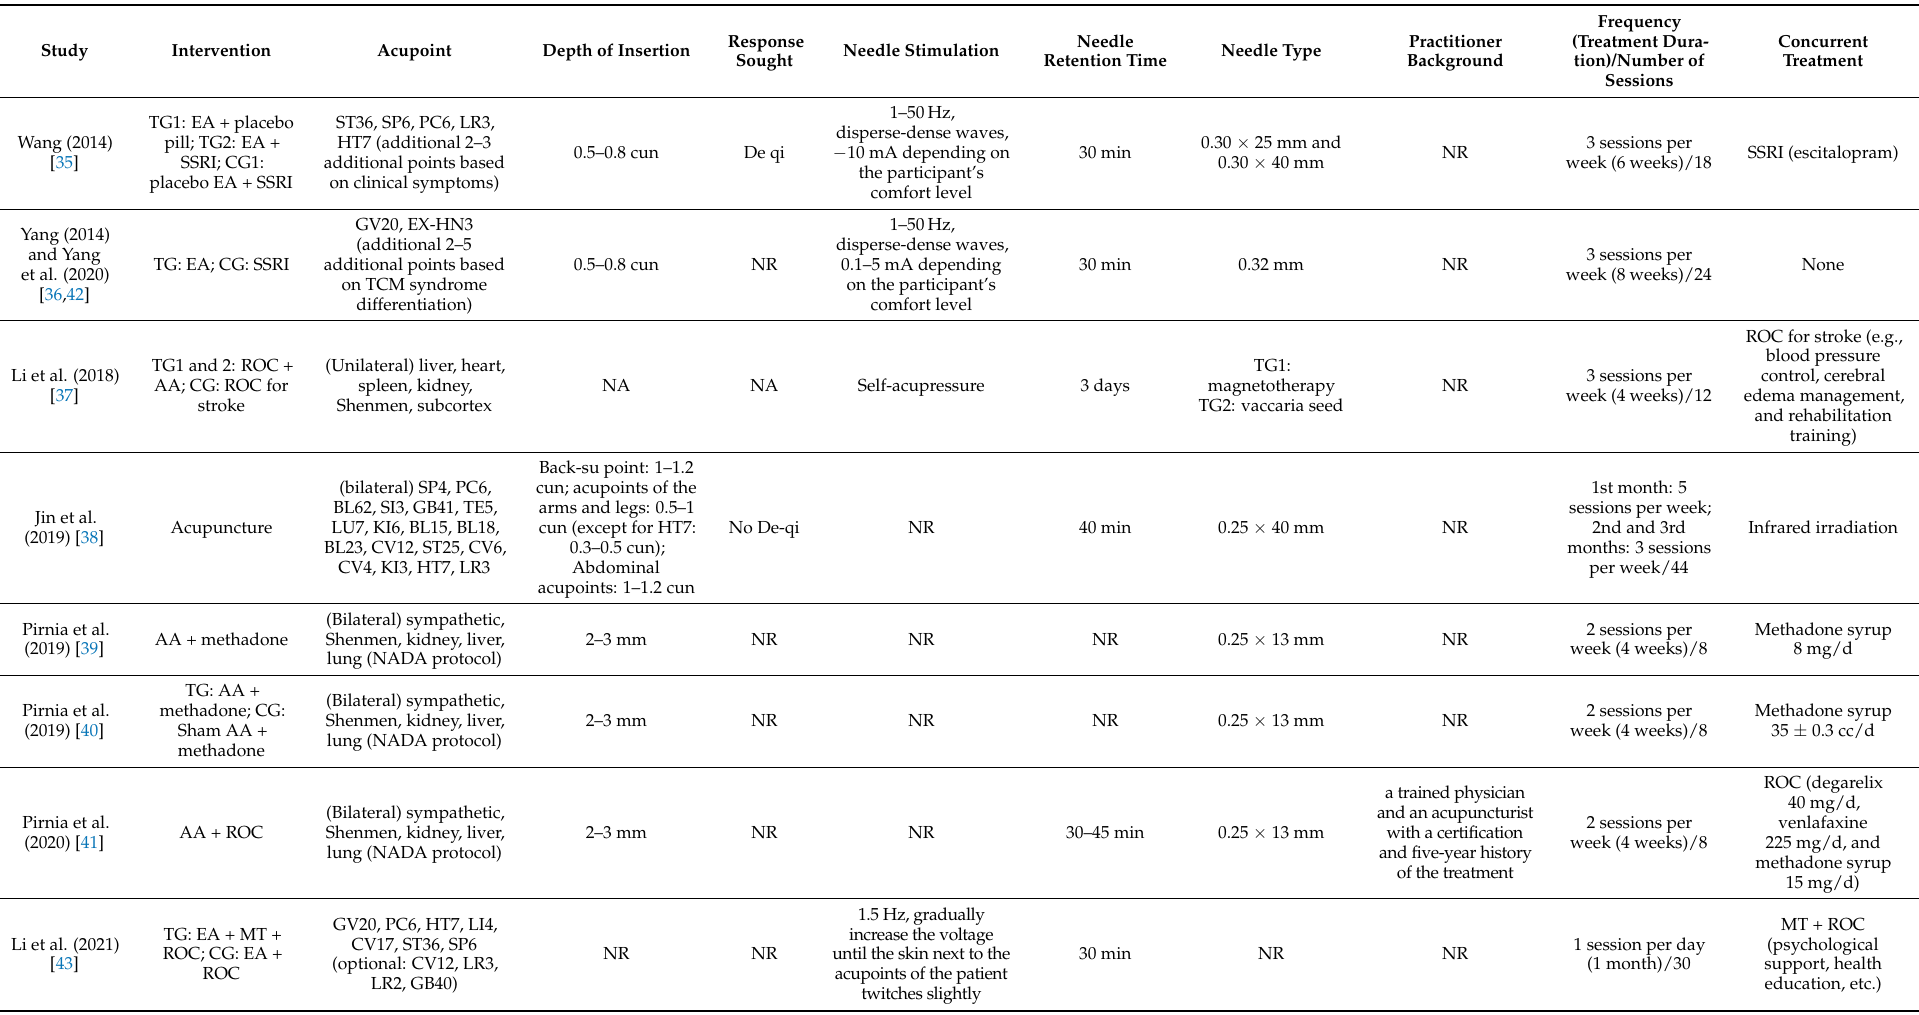
Table 3. Details of acupuncture procedures among included